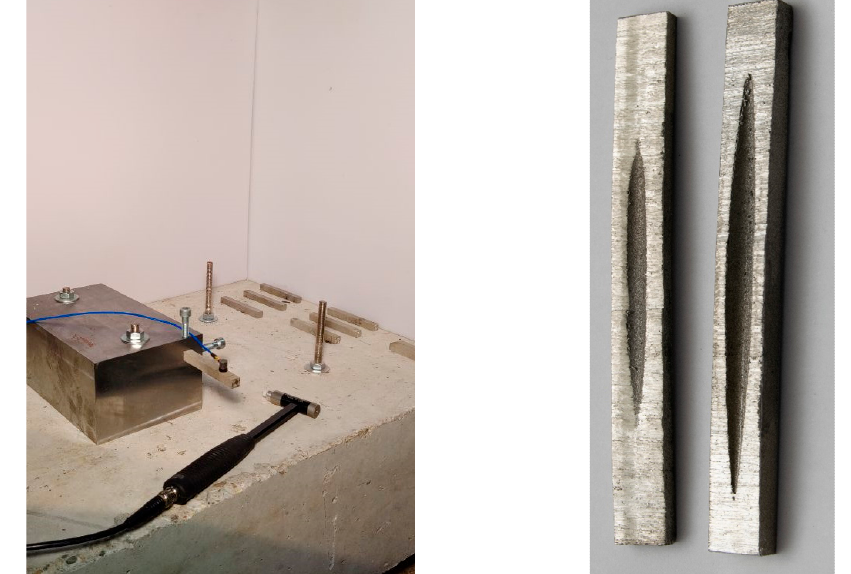
Figure 6. Measurement setup for the free oscillation test and the cross section of a sample. (left: mesurment setup, right: crosssection of sample VH5)